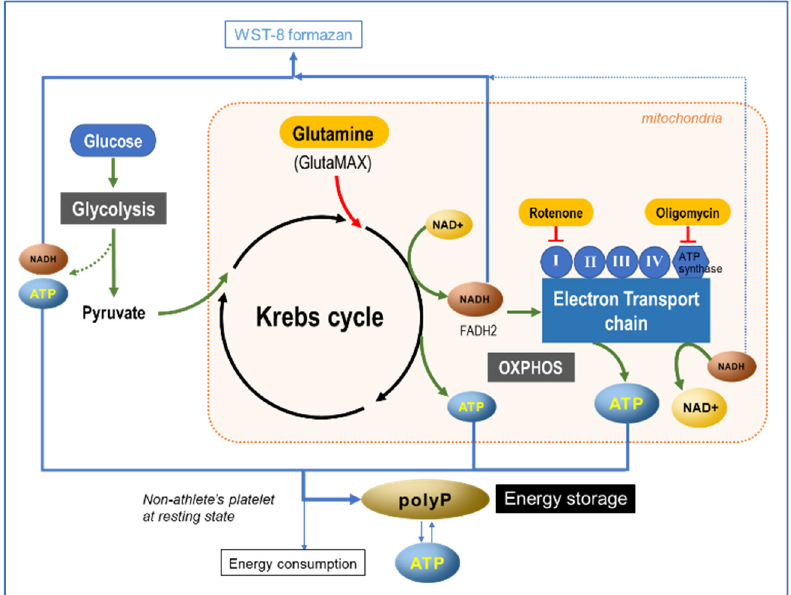
Figure 12. Proposed mechanism of polyP conversion from ATP in resting platelets of non-athletes.